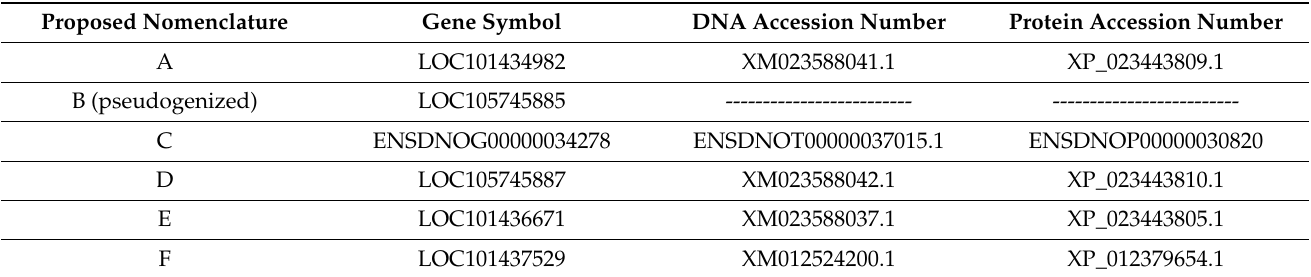
Table 2. Proposed nomenclature for FCRL6 gene copies in D. novemcinctus